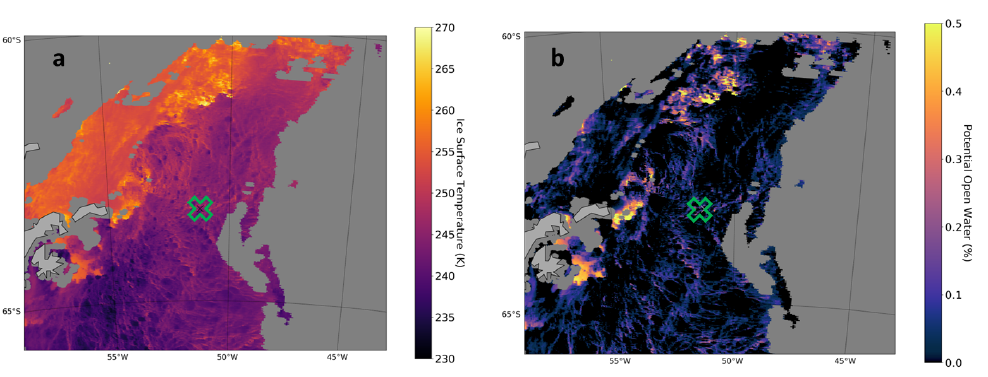
Figure 18. Ice surface temperature ( a ) as seen from the MODIS sensor and derived potential open water ( b ). The scene was acquired by the satellite Terra at 04:55 UTC on 31 July 2013. The green crosses in the middle indicate the position of Polarstern . Grey areas are masked due to land and cloud coverage.